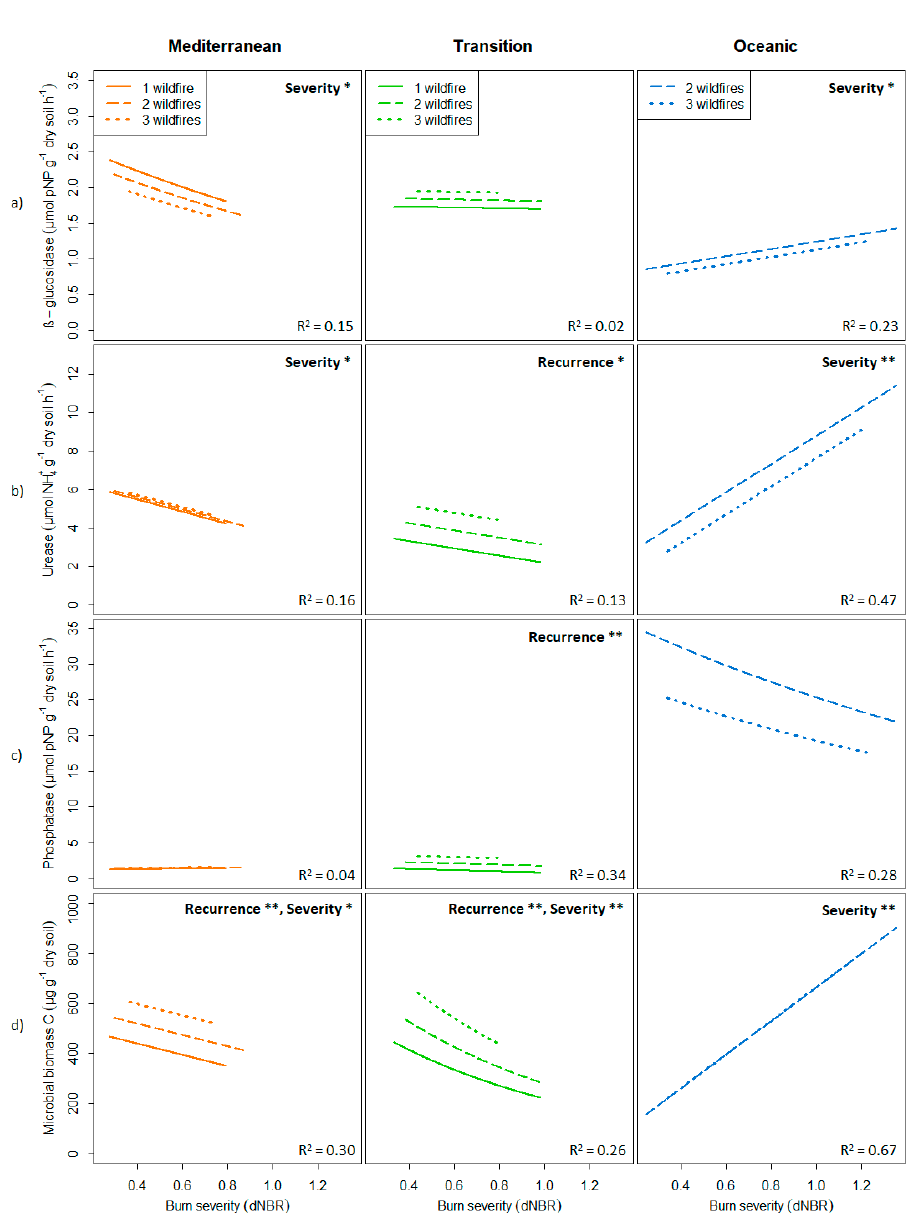
Figure 2. Mean predicted ( a ) β -glucosidase, ( b ) urease, ( c ) and phosphatase activities, and ( d ) microbial biomass C in relation to fire frequency (number of fires) and severity (dNBR of the last fire) at the Mediterranean (panels on the left, orange), Transition (panels in the centre, green), and Oceanic (panels on the right, blue) sites. R 2 values indicate the mean generalized variance explained by the GLMMs. Significance of model predictors (frequency and severity) is represented by * ( P < 0.05) and ** ( P < 0.01).